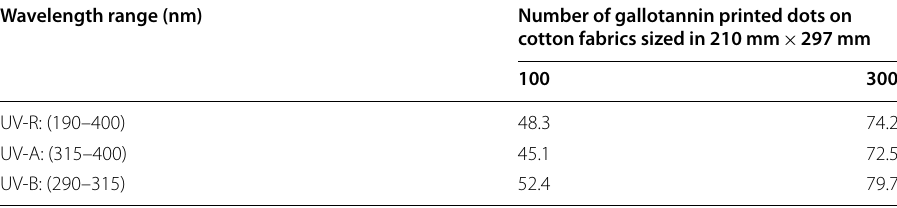
Table 3 Ultraviolet (UV)-blocking rate (%) of gallotannin printed cotton fabrics Wavelength range